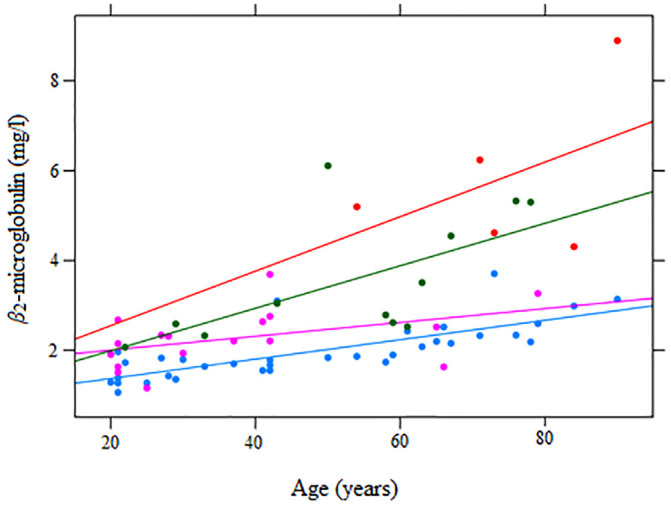
β2-m levels in Covid-19 on admission to the hospital.Serum β2-m levels (mg/l) measured at the time of first SARS-Cov-2 detection are shown in relation to age in a group of 17 patients with mild (magenta ), 12 patients with moderate (green ) and five patients with severe Covid-19 (red ) and 34 approximately age-sex matched uninfected controls (light blue ). Each dot represents one participant. Linear regression lines of β2-m levels on age per group are also included.